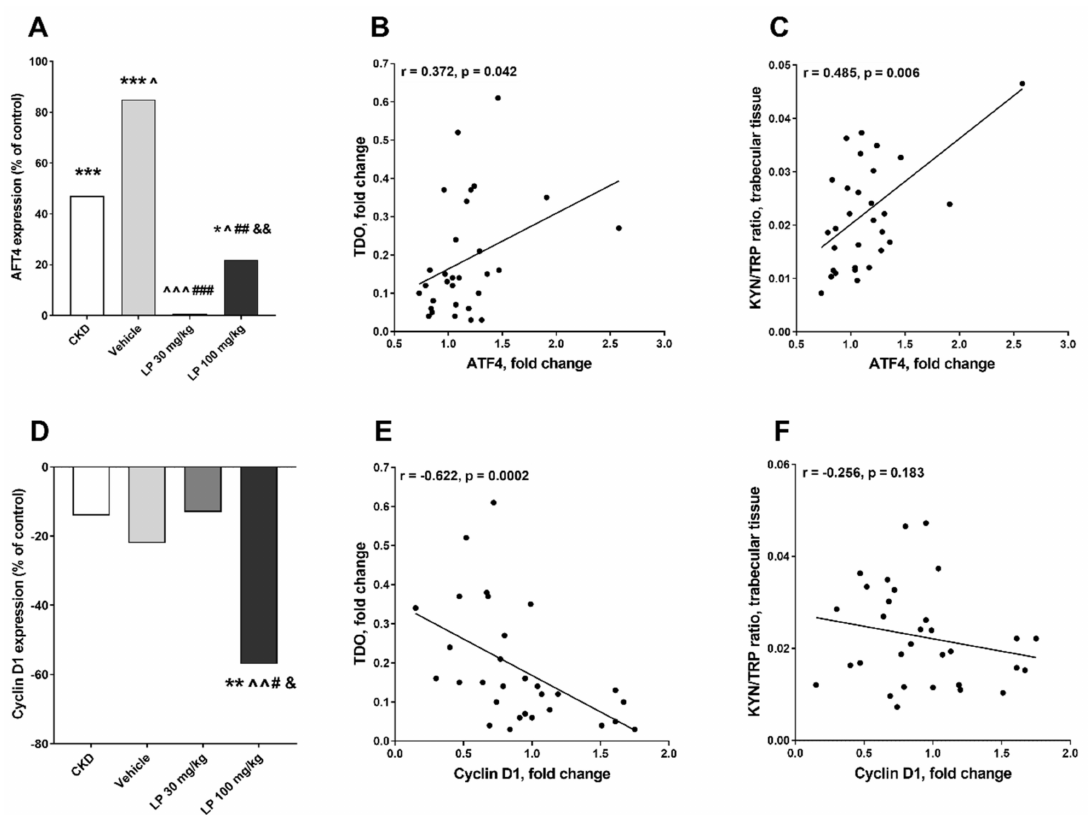
Figure 6. Changes in activating transcription factor (ATF4) and cyclin D1 gene expression among experimental groups ( A , D ), and their associations with tryptophan 2,3-dioxygenase (TDO) expression ( B , E ), and kynurenine to tryptophan (KYN / TRP) ratio in trabecular bone tissue ( C , F ) in rats with CKD treated with LP533401. Data relate to the control taken as 0%. * p < 0.05, ** p < 0.01, *** p < 0.001, control vs. others; ˆ p < 0.05, ˆˆ p < 0.01, ˆˆˆ p < 0.001, CKD vs. others; # p < 0.05, ## p < 0.01, ### p <